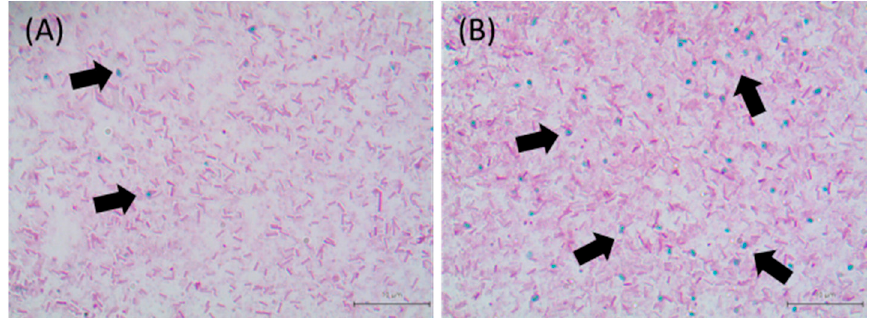
Figure 2. Microscopy images of TYJAM-D-66 sporulation in planktonic ( A ) and sessile ( B ) cells incubated for 3 days in a DS medium. Spores stained with malachite green appear green/blue (black